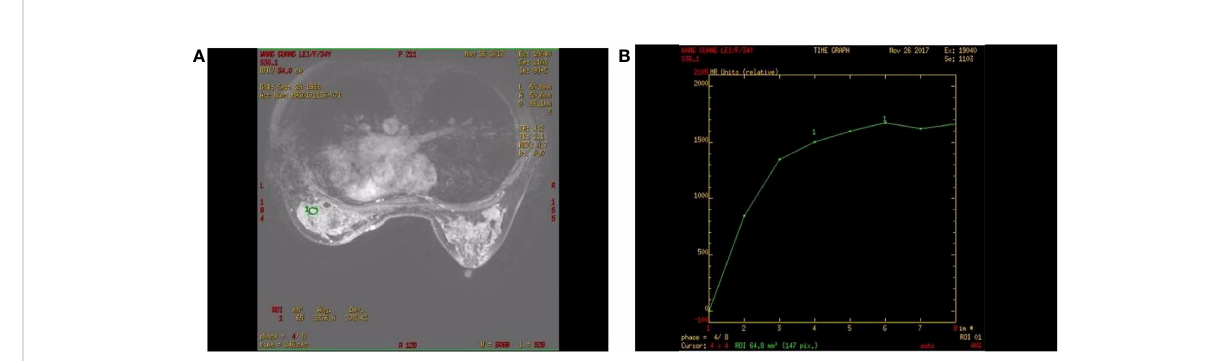
FIGURE 5 Contrast-enhanced magnetic resonance imaging of a patient with angiosarcoma of the left breast. (A) Progressive enhancement of the tumor on continuous dynamic enhancement scans; (B) Enhanced scan curve shows in fl ow